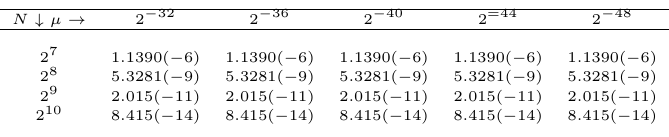
Table 7. Maximum absolute errors in the solution of Example 3 for (cid:15) = 2 − 16 N ↓ µ → 2 − 32